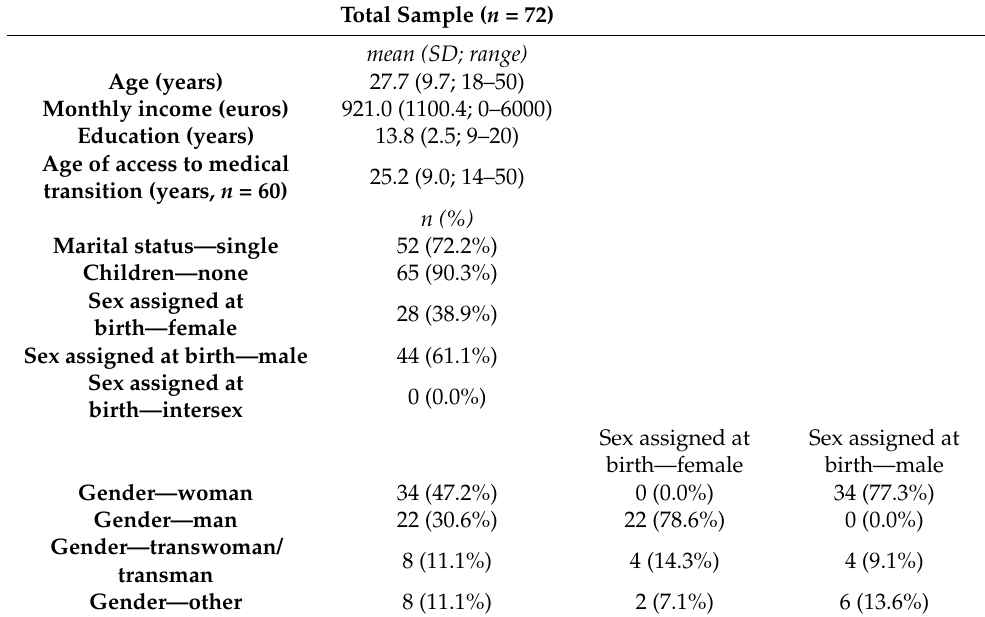
Table 1. Socio-demographic